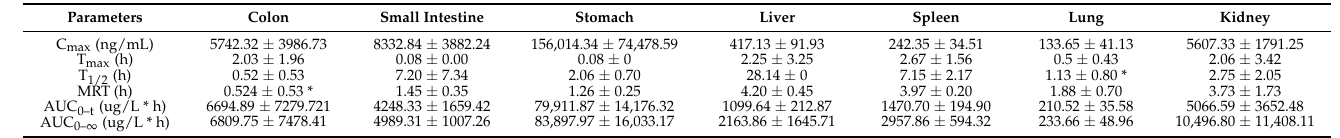
Figure 3. Tissue distribution profiles of myricetin in DSS-group mice and normal-group mice. Data are expressed as mean ± SD (n = 3). The mice were orally administered 50 mg/kg M10 and terminated after 5 min, 15 min, 30 min, 1 h, 2 h, 4 h, 6 h and 8 h in order to collect tissues. Table 2. Pharmacokinetic parameters of M10 in DSS-group mice tissues after oral administration of M10 at a dose of 50 mg/kg (mean ± SD, n = 3).